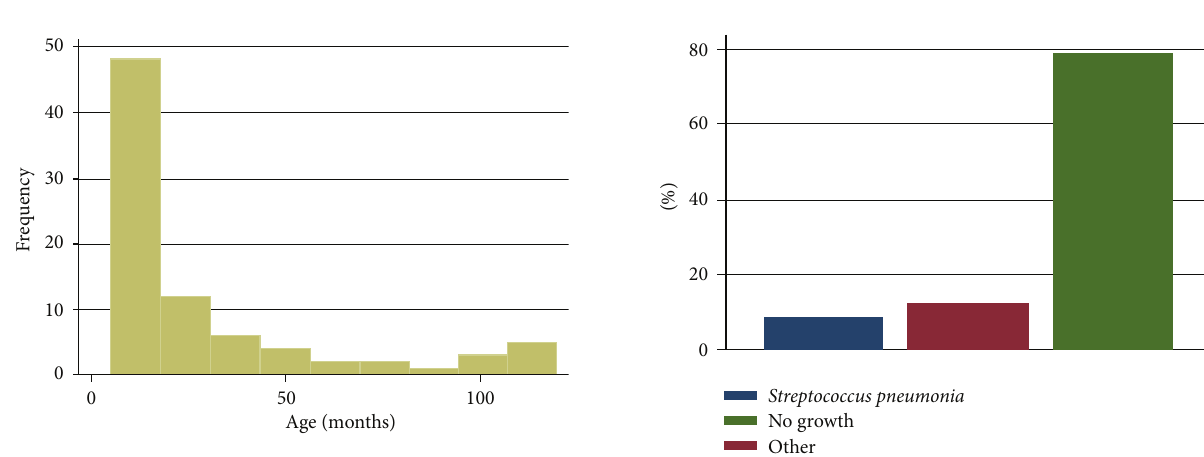
Figure 1: Age distribution (in months) of children evaluated. Table 1: Mean and median age ranges. Mean (SD) Median (range) 29.09 (31.71) 14 (5–120)